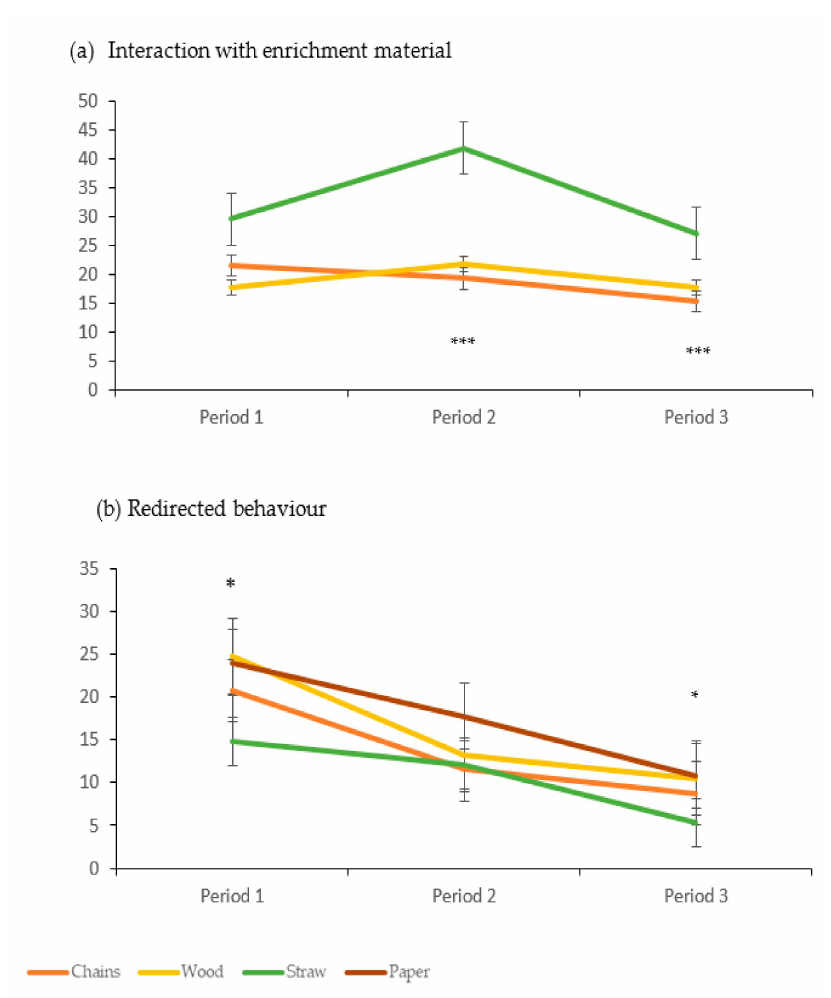
Figure 2. The behaviour observed by focal sampling (Mean counts and SE) for the four types of enrichment materials. 1-3: averaged observations for first, second and third month of observations. * P < 0.05, *** P < 0.001 (see text for explanation of statistical di ff